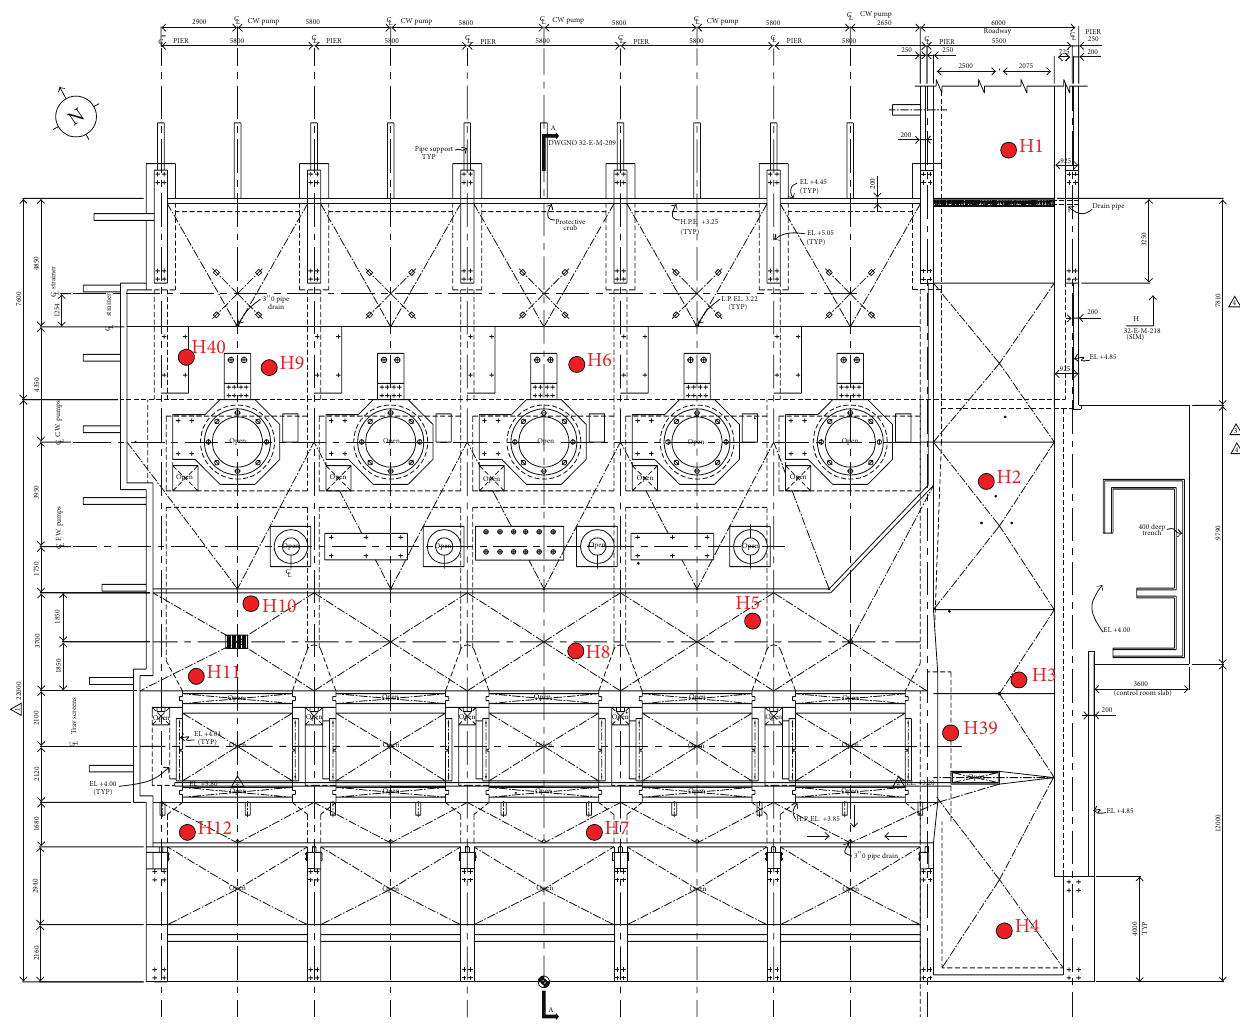
Figure 8: Hammer test location at train A/B.